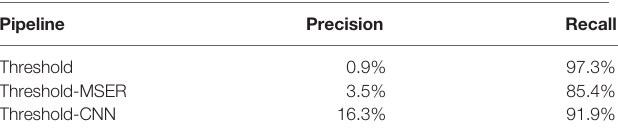
TABLE 3 | Precision and recall values of the automated pipelines evaluated against the 3,356 ground truth